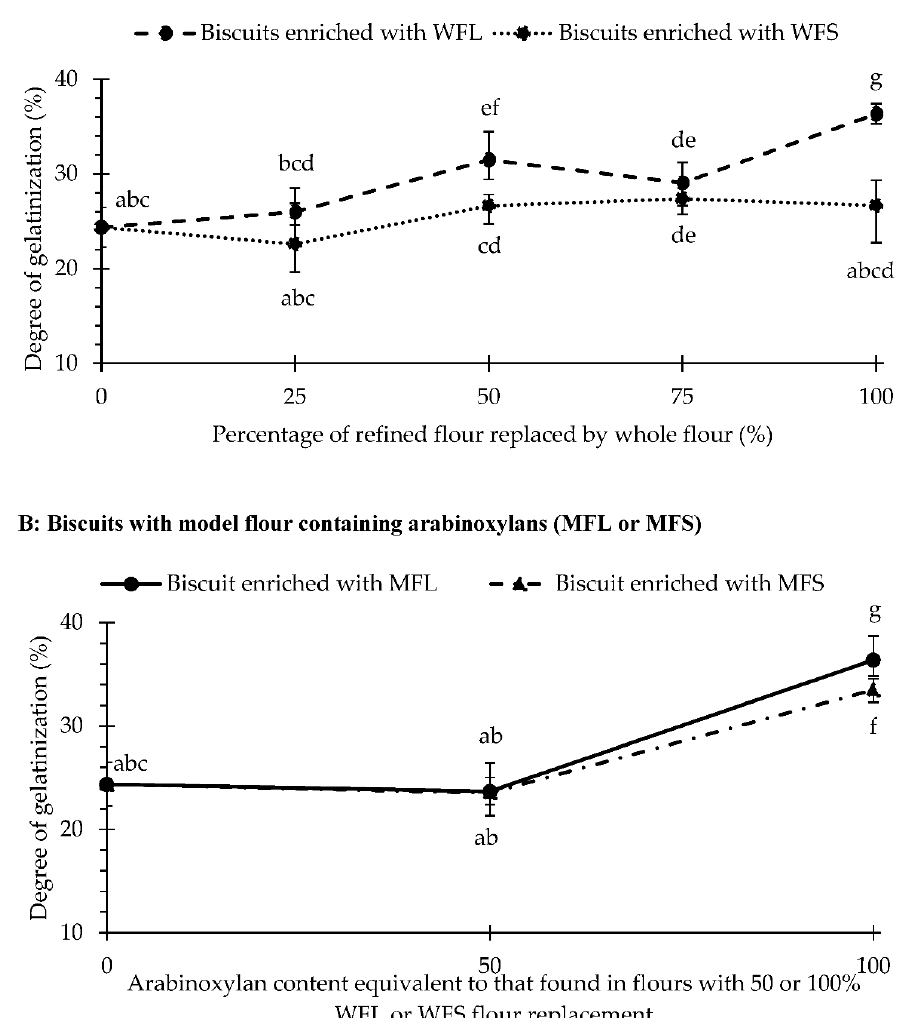
Figure 4. Degree of starch gelatinization (%) in rotary-moulded biscuits produced with refined flour, with doughs prepared replacing 25, 50, 75 or 100% of the refined flour with whole flour with coarse bran (WFL) or with whole flour with fine bran (WFS) ( A ), and with model flours enriched with arabinoxylan with an equivalent content to that found in flours with 50 or 100% whole flour replacement (MFL: coarse bran; MFS: fine bran) ( B ). Data are observed mean ± confidence intervals at 95%. Different script letters refer to significant difference ( p < 0.05).